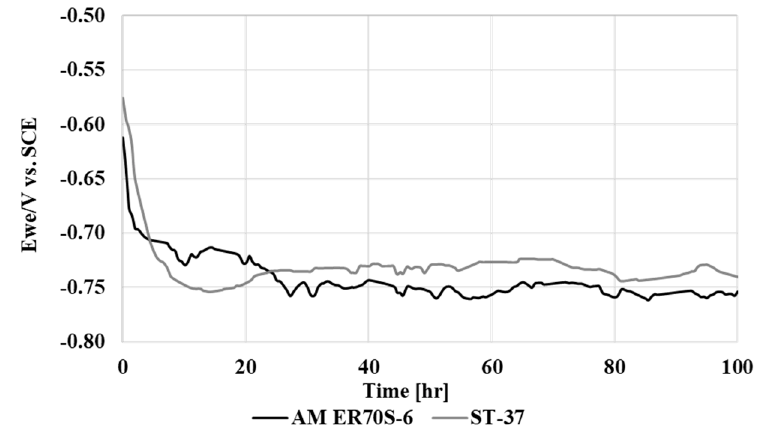
Figure 3. Open circuit potential of additively manufactured ER70S-6 alloy and counterpart ST-37 alloy in 3.5% NaCl solution.